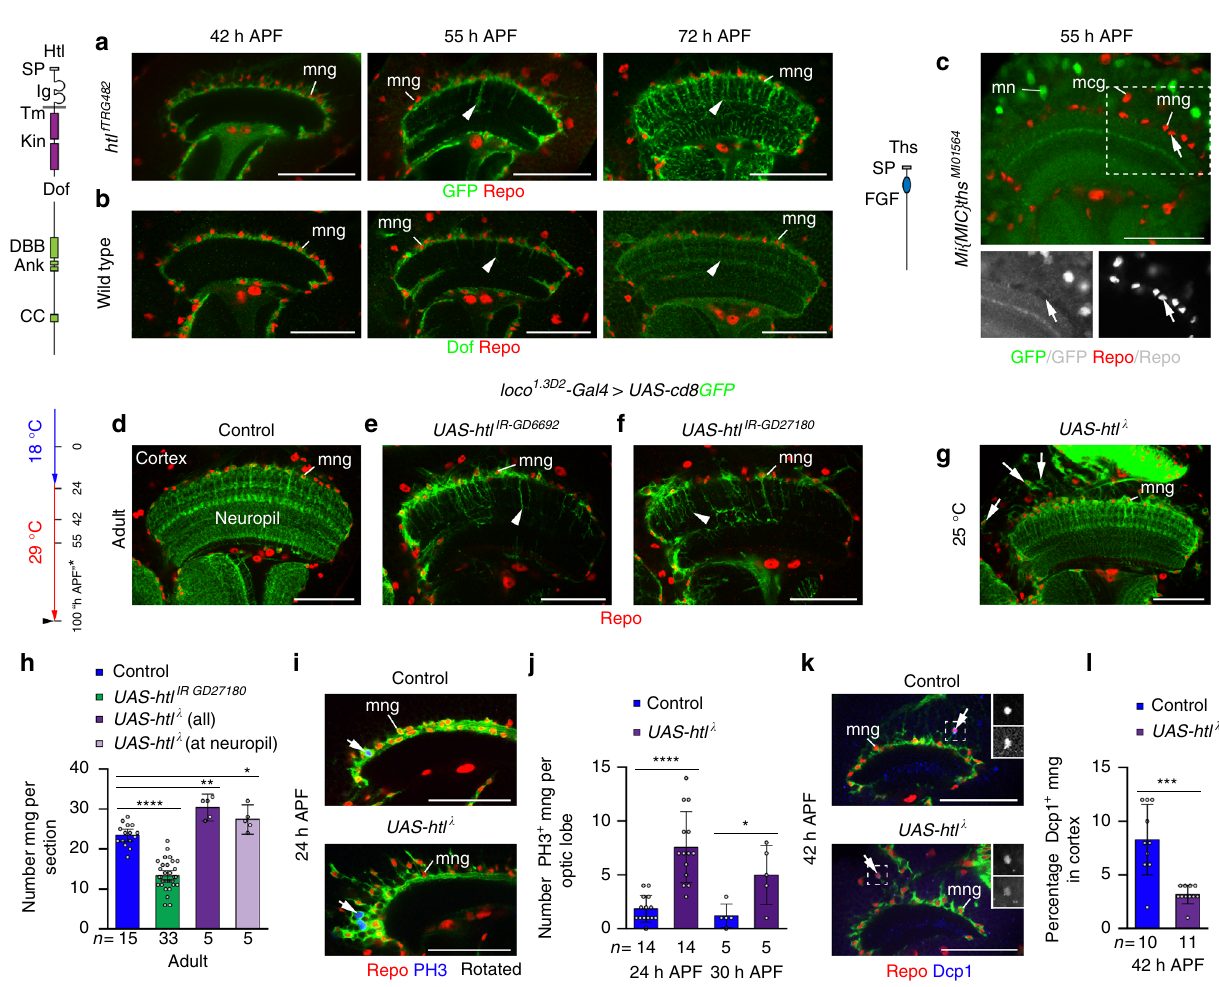
Fig. 7 FGF signaling regulates astrocyte-like mng development. Repo labeled glial nuclei ( red ). a htl fTRG482 reports Htl expression ( green ) at 42, 55, and 72 h APF in mng cell bodies and processes ( arrowheads ). b Dof ( green ) labeling of wild-type OreR optic lobes showed a similar expression pattern. c At 55 h APF, Mi{MIC}ths MI01564 reports Ths production in medulla neurons (MN), but not glia ( arrows ) including mng or medulla cortex glia (MCG). Ank ankyrin repeat, DBB Dof-BVAP-BANK domain CC coiled-coil domain, Ig immunoglobulin domain, Kin kinase, SP signal peptide, Tm transmembrane domain. d – g , I , k mng were labeled with loco 1.3D2 -Gal4 UAS-cd8GFP ( green ). Following expression of UAS-htl IR-GD6692 ( e ) and UAS-htl IR-GD27180 ( f ) adult mng showed reduced primary and secondary processes in the neuropil ( arrowheads ) compared to controls ( d ). Samples were shifted to 29 °C at 21 h APF. Asterisk , time points are adjusted to h APF at 25 °C. g Expression of constitutively active htl λ in mng did not affect branch extension into the neuropil. Surviving mng are ectopically positioned in the medulla cortex ( g , arrows ). h Quanti fi cation of mng numbers. Htl knockdown decreases and over-activation increases mng numbers. The scatter plot with bars shows data points and means ± 95% con fi dence intervals ( n = optic lobes (single optical sections)). i , j Numbers of mitotic PH3-positive mng ( blue ) increased following Htl over-activation at 24 and 30 h APF. k , l The percentage of apoptotic Dcp1-positive mng ( blue , bottom insets ) per optic lobe in the cortex decreased following Htl over-activation at 42 h APF. The scatter plots with bars j , l show data points and means ± standard deviation ( n = entire optic lobes). Unpaired, two-tailed Student ’ s t- test not assuming equal variance were: P = 9.84× 10 − 13 , P = 0.0017, P = 0.0372 ( h ), P = 1.39 × 10 − 5 , P = 0.0327 ( j ), and P = 0.0007 ( l ). * P < 0.05, ** P < 0. 01, *** P < 0.001, **** P < 0.0001. All image panels show single optical sections. For genotypes, sample numbers and additional statistical values, see Supplementary Tables 1 and 2. Scale bars , 50 μ anchoring their cell bodies in this location to ensure their survival.